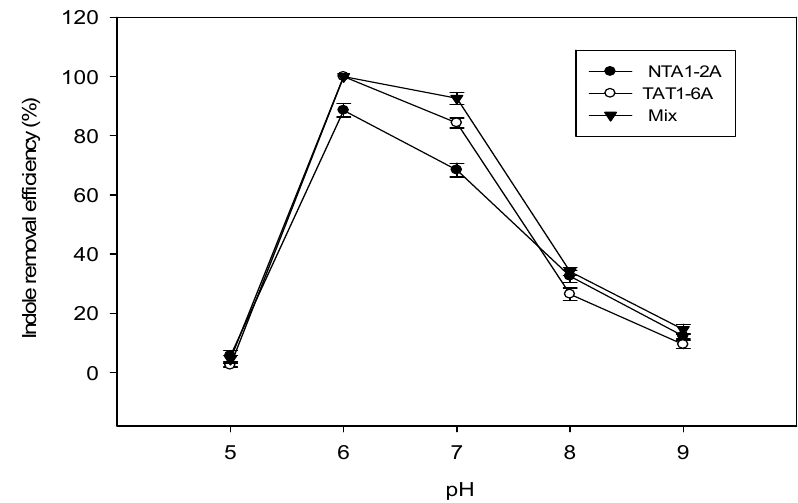
Figure 5. Effect of pH on indole removal efficiency (%) at 31 °C and 117.15 mg/L (1.0 mM) of indole concentration incubated for 96 h. Error bars: Mean ± SE of three replicates.